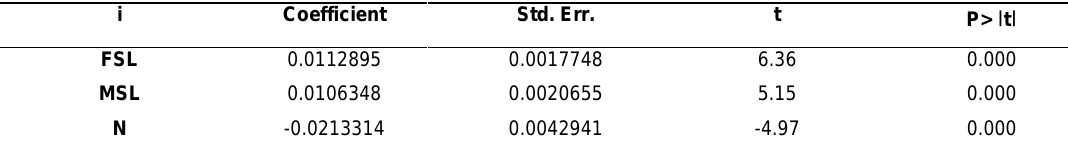
Table 3: The Results of Estimation of Supply Functions for